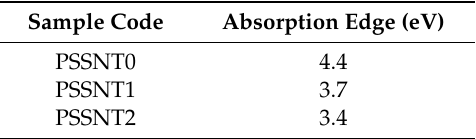
Figure 4. Absorption coefficient as opposed to photon energy for pure PS (PSSNT0), PSSNT1, and PSSNT2 nanocomposite films. Table 3. Pure PS and PS nanocomposites absorption edge values.